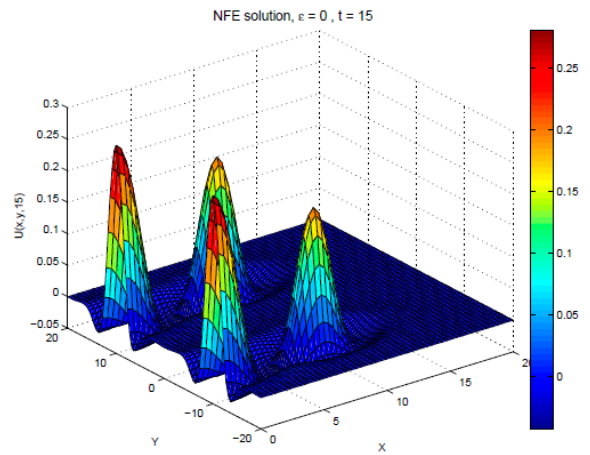
Figure 14. Snapshots of the solution of Example 3 at time t = 12: up- E = 0; down, left-hand side -E = 0.04; down, right- hand side - E = 0.08